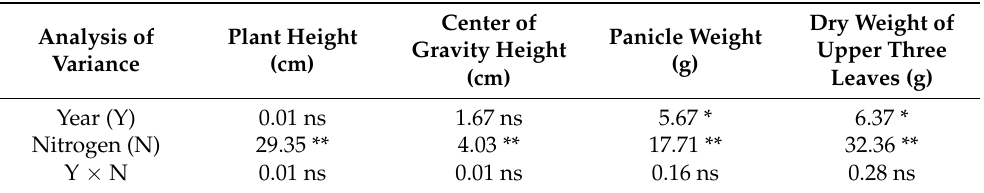
Table 4. Analysis of variance of main stem characteristics.